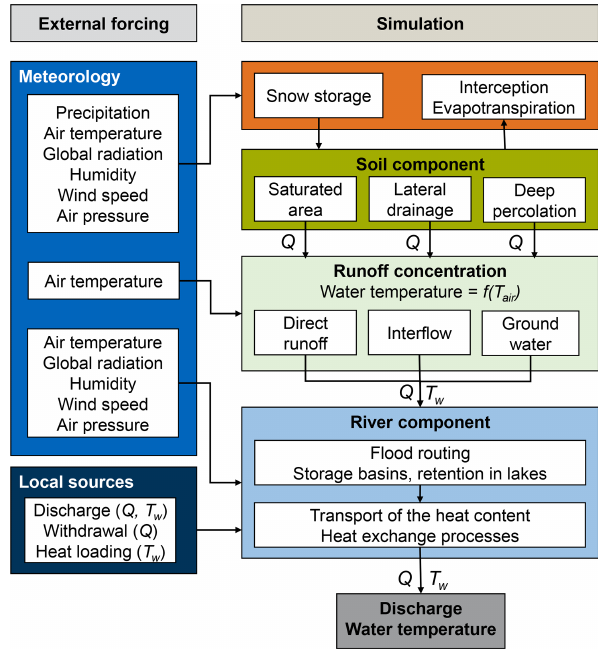
Figure 2. LARSIM water balance model. Source based on Ludwig and Bremicker